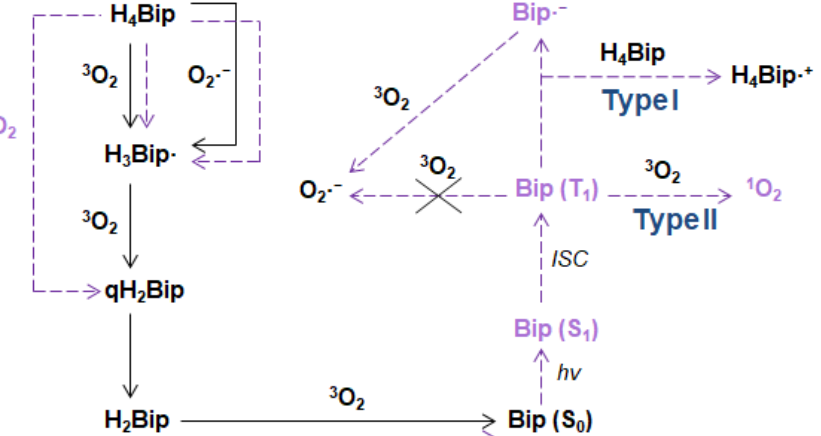
Figure 13. The scheme of H 4 Bip autoxidation (solid lines) and photooxidation (dashed lines) [30]. © 2022 Taylor and Francis.